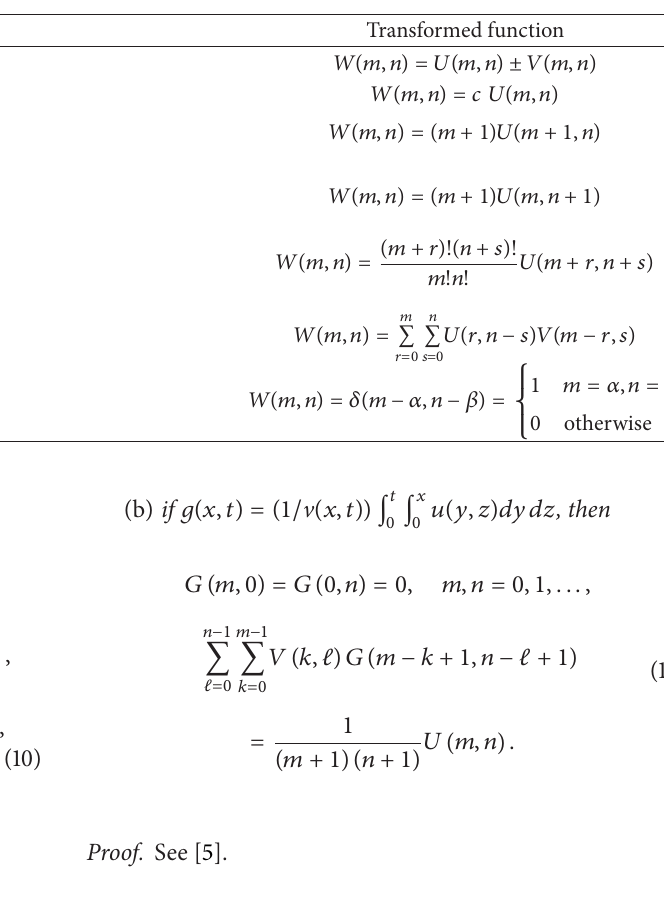
Table 1: The fundamental operations of two-dimensional differential transform